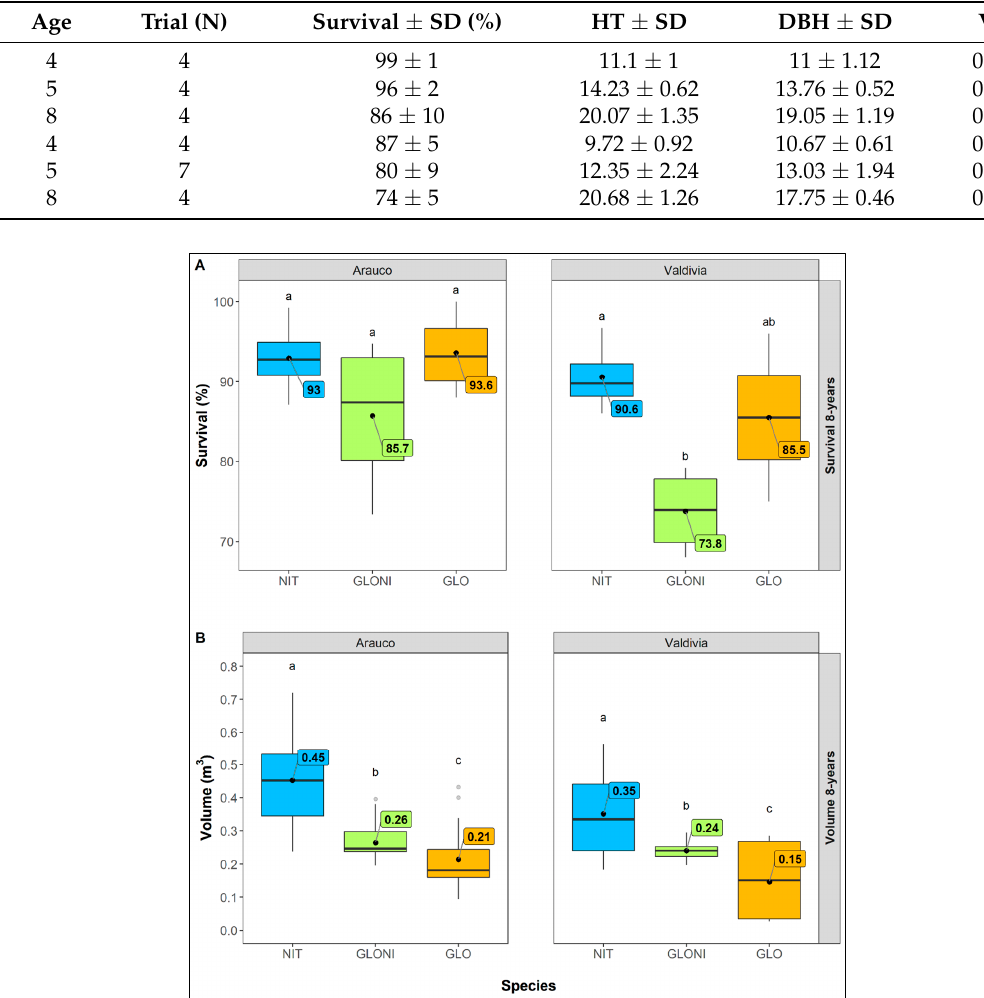
Figure 3. Parental and hybrid phenotypic values in survival (%) and individual tree volume (m 3 ), measured at 8 years in the Arauco and Valdivia breeding zones. ( A ) Survival plots. ( B ) Volume plots. The abbreviation NIT is for E. nitens parents, GLO for E. globulus parents, and GLONI for the hybrid between these species. NIT and GLO survival and volume values were obtained from the pure species controls planted in each hybrid field test. Black dots represent the mean of survival and volume, with their value on a label near to the dot for each species within a zone. The Tukey HSD significance test for differences in the means Volume (m 3 ) and Survival (%) was performed within a zone, where different letters indicate statistically significant differences ( p <